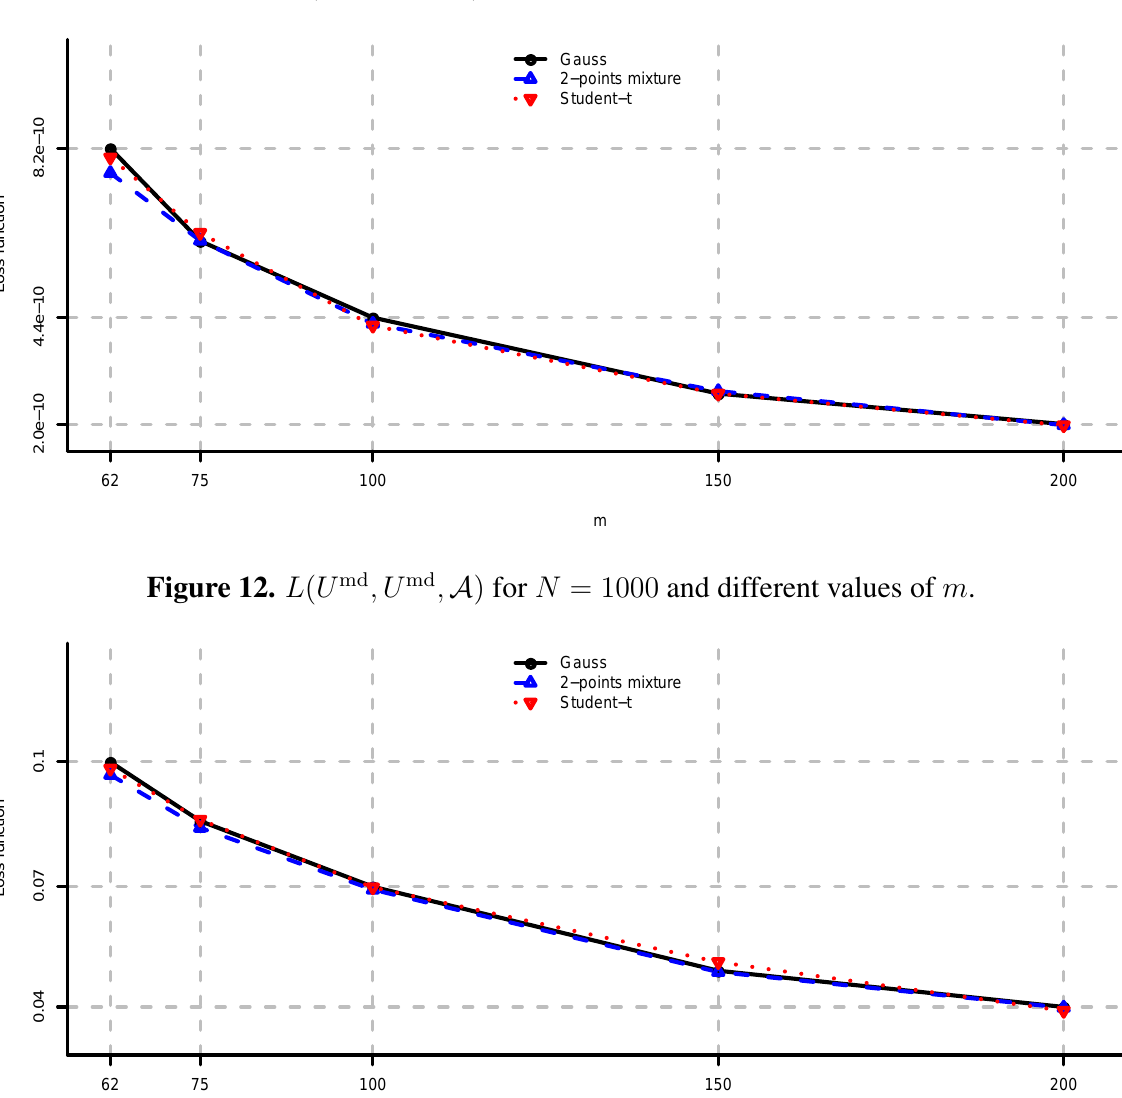
Figure 11. L ( U ecr , U ecr , A ) for N = 1000 and different values of m .